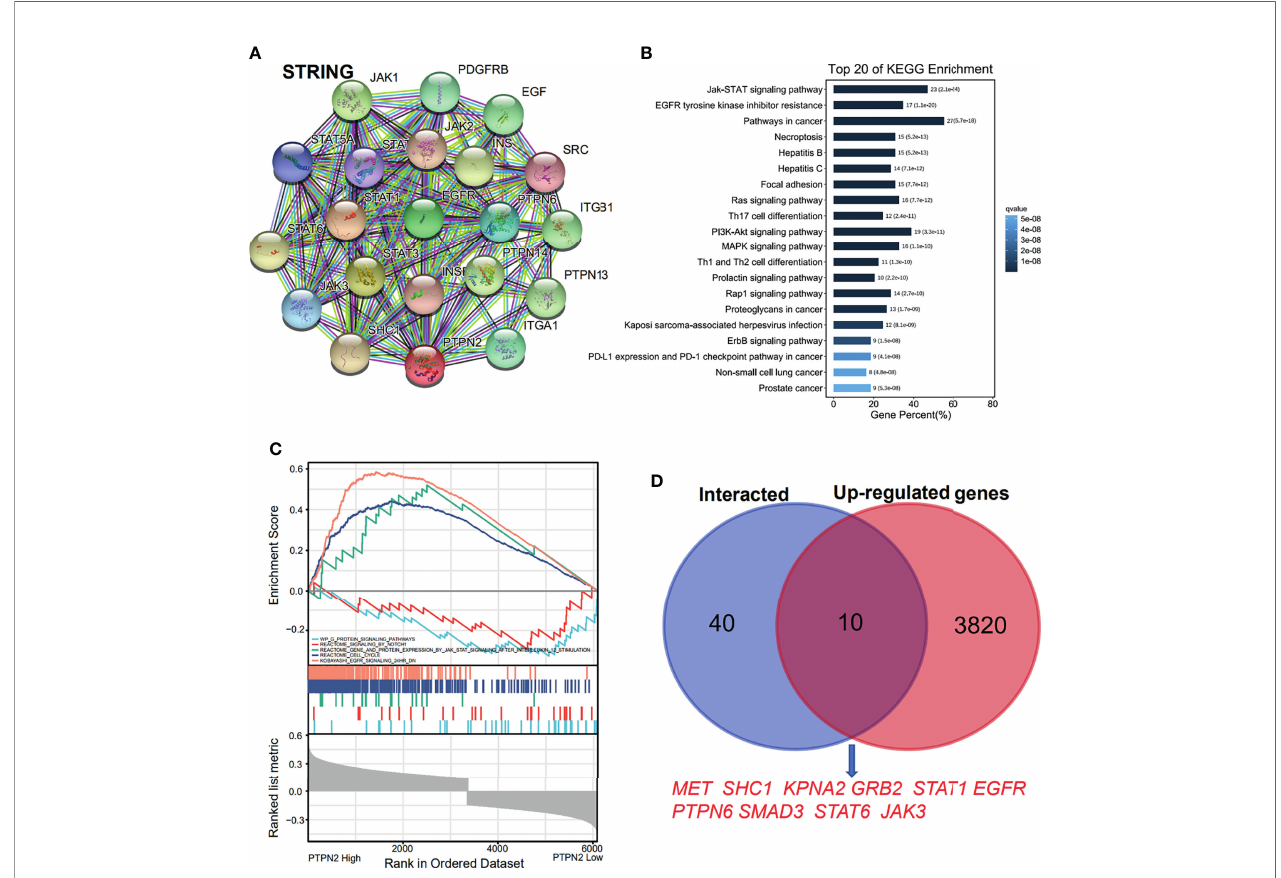
FIGURE 9 | Proteins that interact with PTPN2 and PTPN2 related pathway enrichment in pancreatic adenocarcinoma. (A) The PPI analysis of PTPN2 (STRING). (B) KEGG enrichment of the PPI genes. (C) GSEA enrichment of the PTPN2 correlated genes. (D) online prediction of the common genes in PTPN2 PPI network and PTPN2 positively correlated